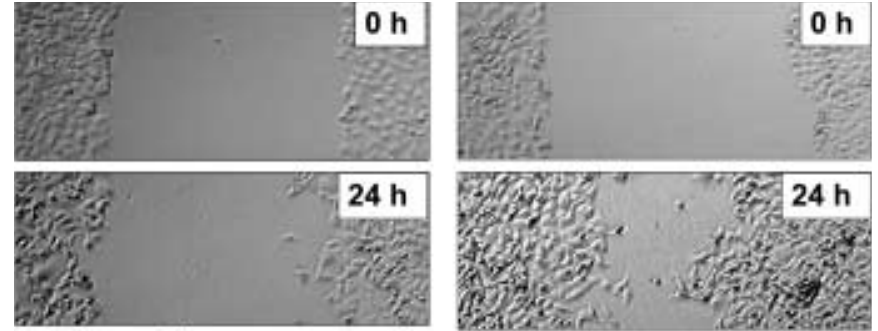
An in vitro alveolar epithelial wound repair model was established to determine the ep- ithelial repair activity of pulmonary oedema fluid and plasma from patients with ALI/ARDS. Human alveolar epithelial-like cells were grown to a monolayer and after mechanical wounding the cells were incubated with pulmonary oedema fluid from patients. As an example, the effect on alveolar epithelial repair in vitro of plasma (left panels) and pulmonary oedema fluid (right panels) from a patient with ALI/ARDS is shown at 0 and 24 hours after